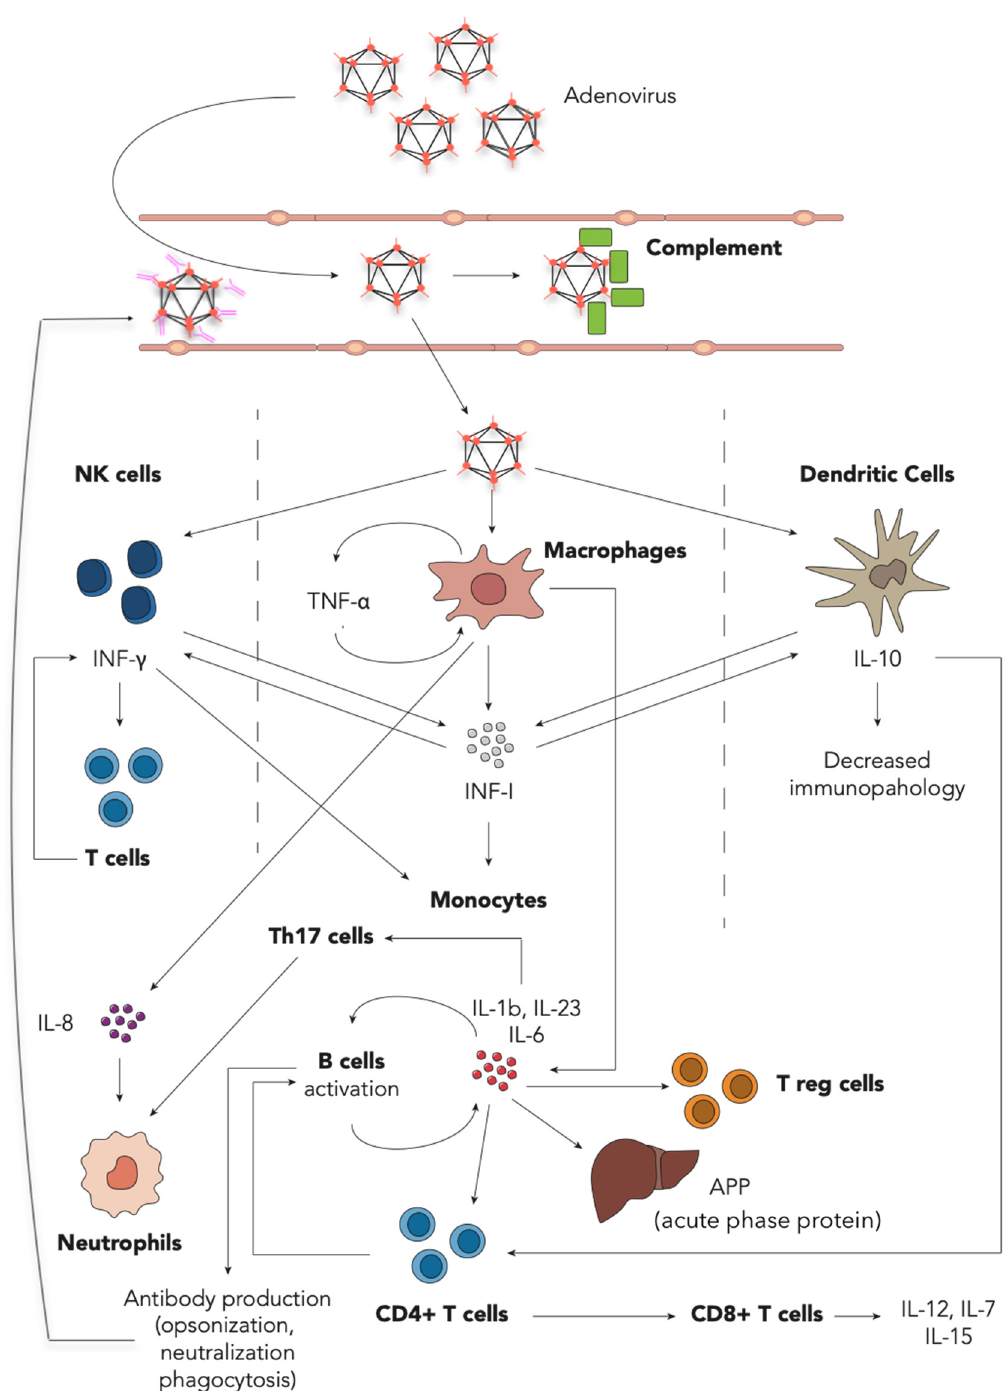
Figure 1. Adenovirus–host interaction during the first days of acute infection. On the top is the reported innate immune response starting with HAdV entry, blood stream invasion, complement activation and C3a release to promote opsonization and phagocytosis. Below, at target organ or tissue, interaction between HAdV and effector of the innate immune response is shown. The entering and sensing of HAdV by Natural Killer (NK) cells, macrophages and Dendritic Cells (DC) (through either penetration [34], phagocytosis of opsonized HAdV or CD46, Sialic Acid, integrins and MHC I interaction [90]) stimulates the production of Type I interferons (IFN-I). IFN-I is secreted in large amounts mainly by specialized DC, and, together with IL-12, IL-15, IL-18 (not shown) and drives the secretion of IFN- γ in NK cells. IFN-I enhances macrophage phagocytosis, activation and the expression of MHC I and MHC II [91]. The former enhances recognition of infected cells by cytotoxic T cells, and the latter, in antigen presenting cells, promotes the presentation and activation of the CD4+ T cell-response. Type